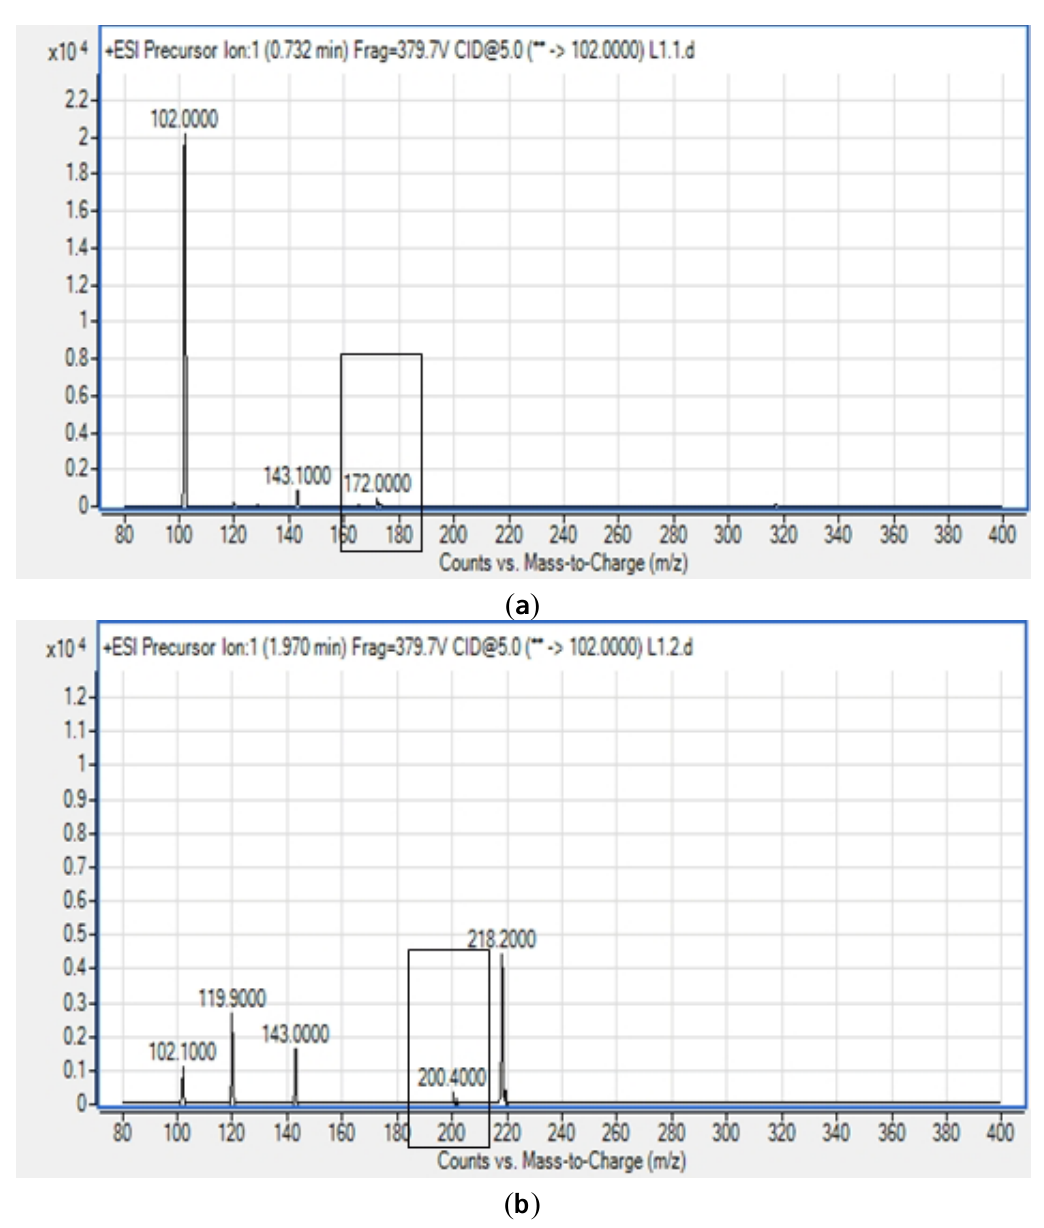
Figure 4. Mass spectra of the extracted AHLs from the spent supernatant of E. asburiae